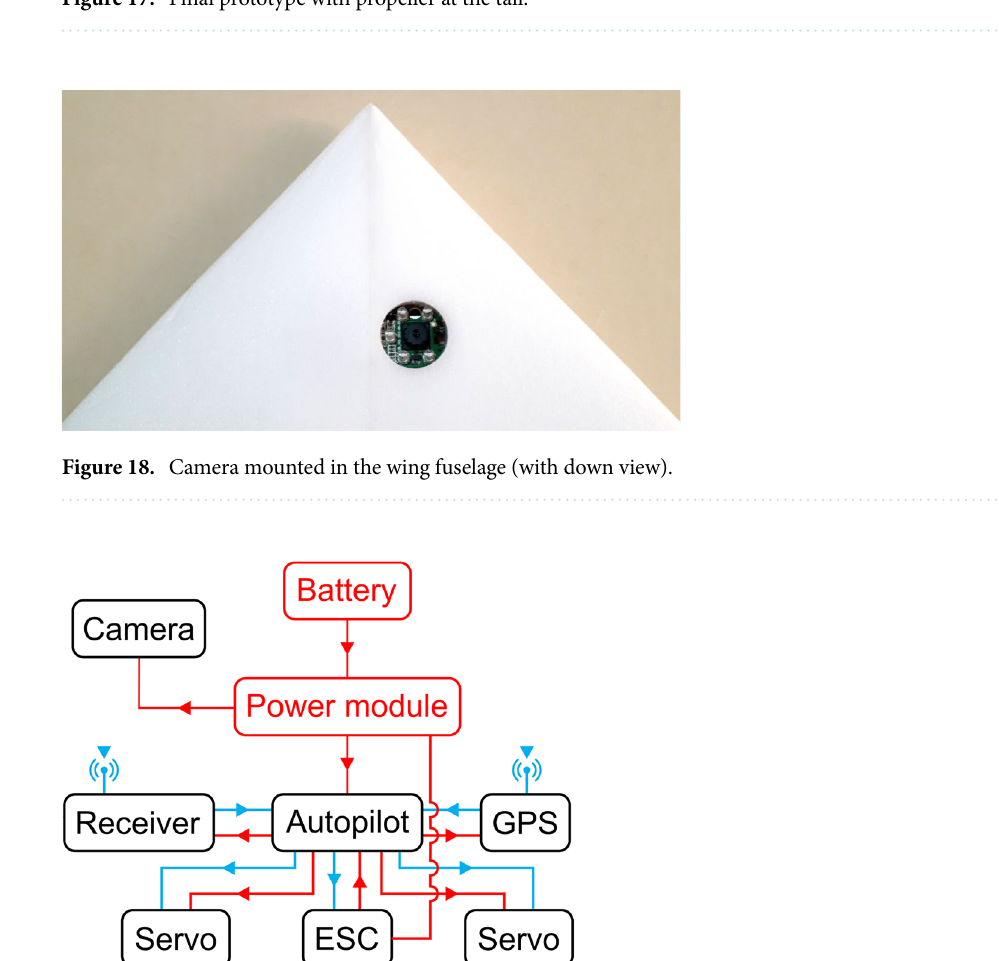
Figure 17. Final prototype with propeller at the tail.